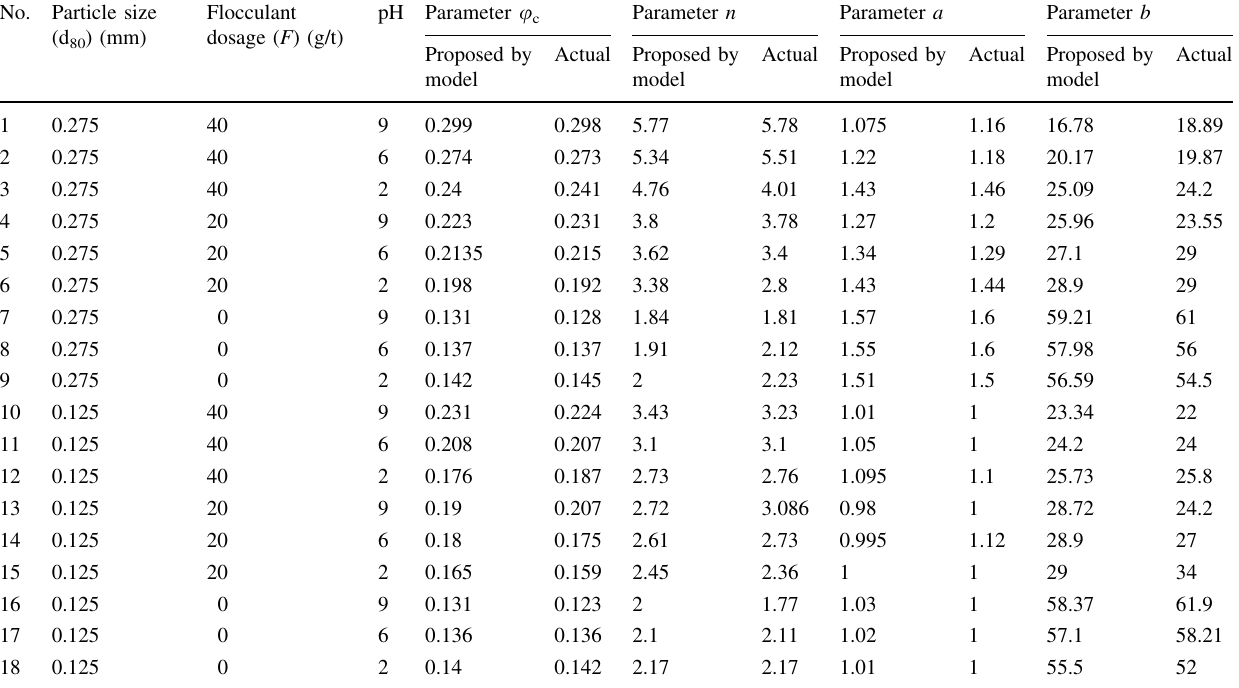
Table 1 Compare of parameters, a , b , n and u c that have been measured using experimental tests and have been predicted using model for input feed to tailing thickener of coal washing plant No. Particle size (d 80 ) (mm)